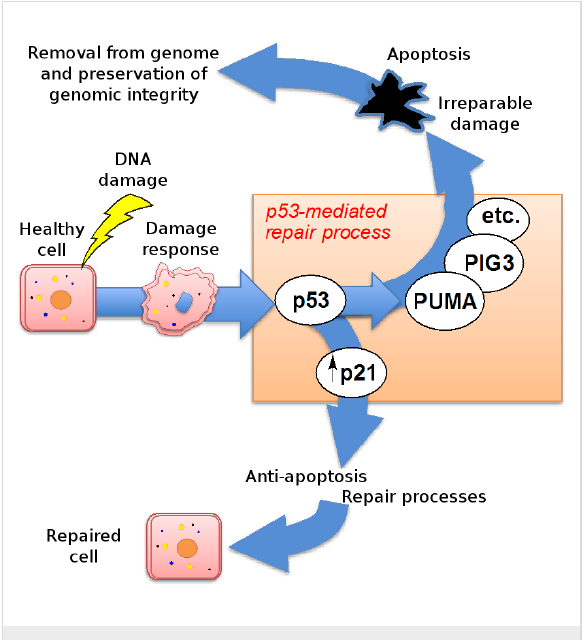
Figure 1: p21 determines the fate of DNA-damaged [13] cells.